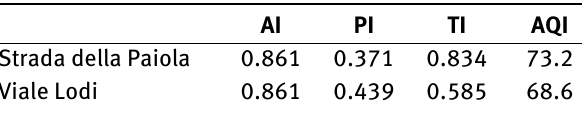
Figure 9: Comparison between the AI calculated with the new pro- posed lower limit (green line) with the previous one (blue line) Table 5: Proposal for a methodology upgrade – Recalculation of the Indicators and the Index of the two